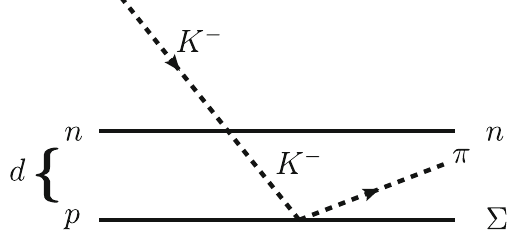
Fig. 18 Mechanism for the K − d → πΣ N